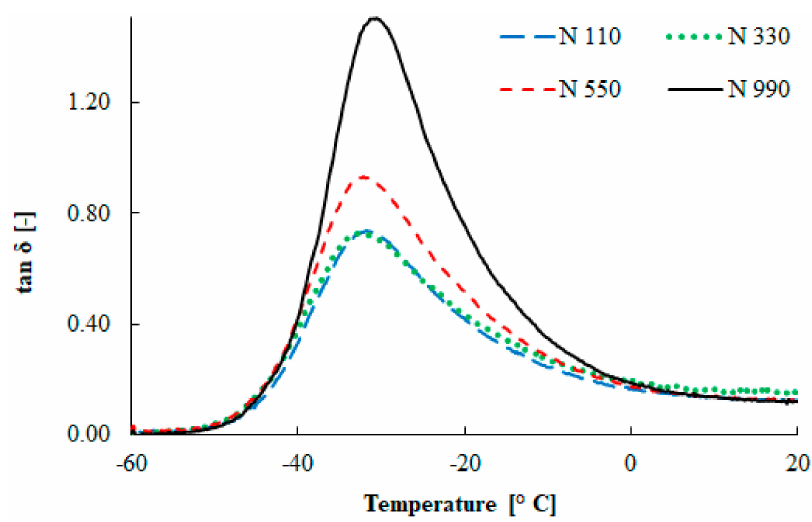
Figure 4. Temperature dependence of the loss